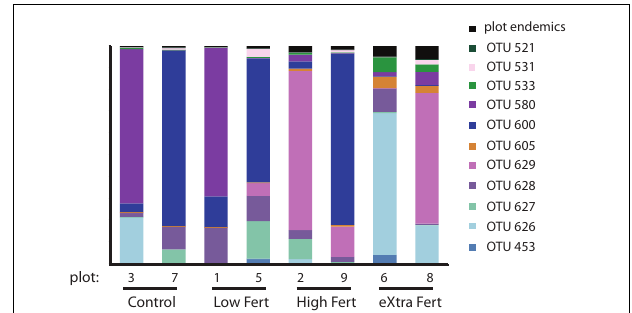
FIGURE 8 | Stacked bar chart identifying the generalist OTUs that were found in all 8 plots along with the relative proportion of sequences that are endemic to each of the plots.